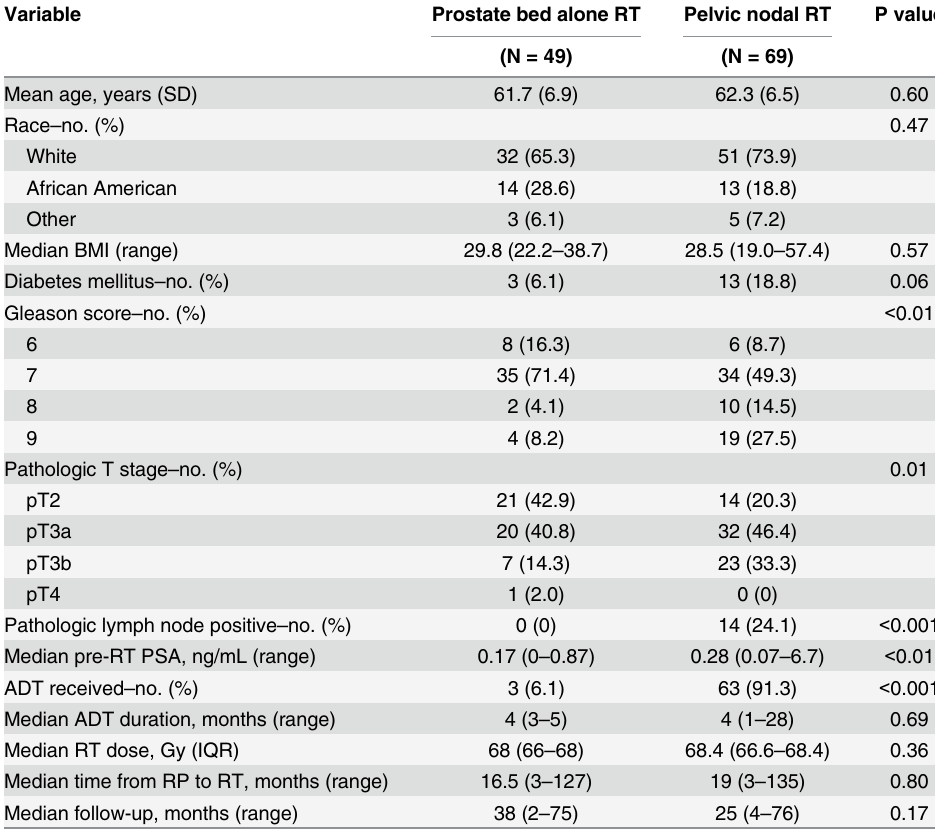
Table 1. Patient and treatment characteristics.